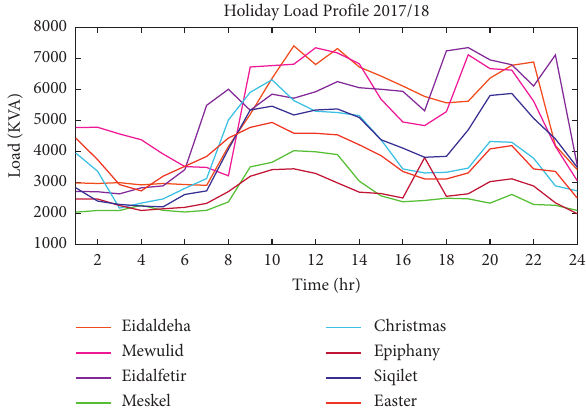
Figure 1: Hourly load profile of religious holidays in 2017/18.